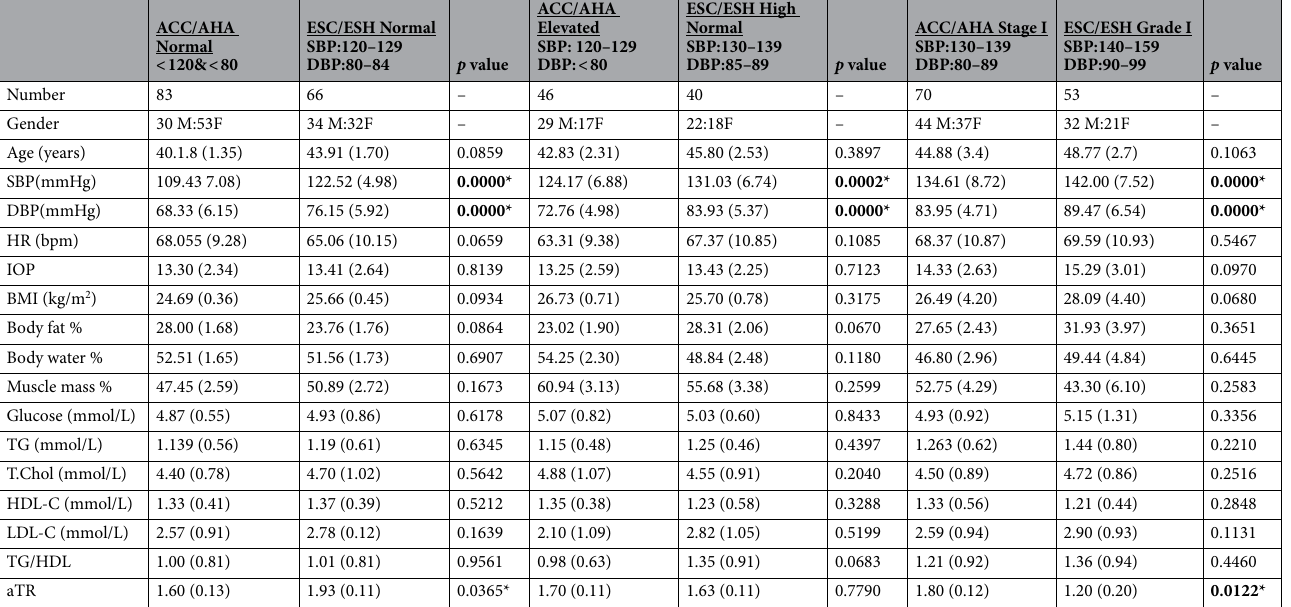
Table 1. General characteristics of the study population. Abbreviations: SBP: systolic blood pressure; DBP: diastolic blood pressure; HR: heart rate; IOP: intraocular pressure; BMI: body mass index; TG: triglycerides; T. Chol: total cholesterol; HDL-C: high-density lipoprotein cholesterol; LDL-C: low-density lipoprotein; aTR: adjusted temperature rebound *Significant p values are indicated where p < 0.05 was considered significant.